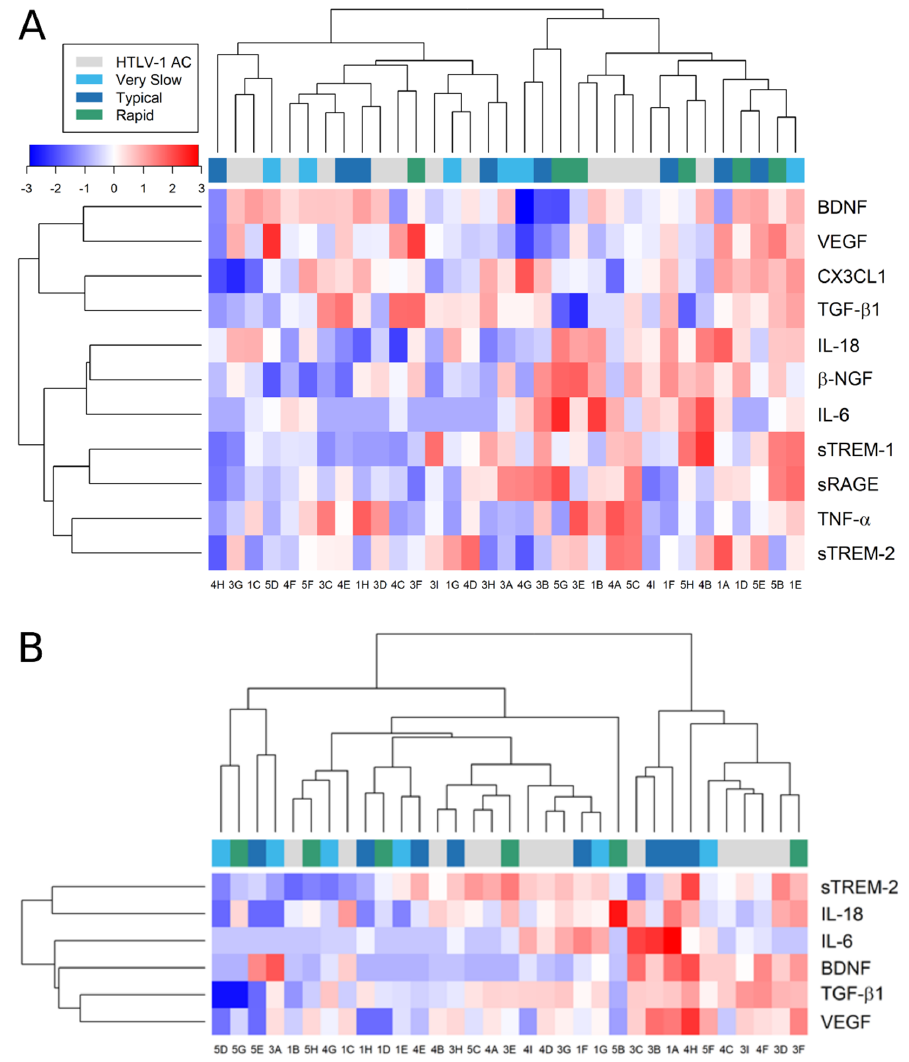
Figure 8. Relative expression of factors associated with neuroinflammatory processes. The concentration of factors listed was determined in the ( A ) serum and ( B ) CSF of asymptomatic HTLV-1 carriers (AC) ( n = 13) and HAM/TSP patients ( n = 20), which were further characterized by the speed of disease progression as very slow (light blue), typical (dark blue), or rapid (green), as previously described [11]. Only factors with detectable levels in more than half of the samples were included in the analysis. Values were log 2 -transformed for heatmap analysis, and the expression normalized for each factor (lines). Reduced expression is represented by shades of blue, increased expression by shades of red, and the median is indicated by 0 (white).